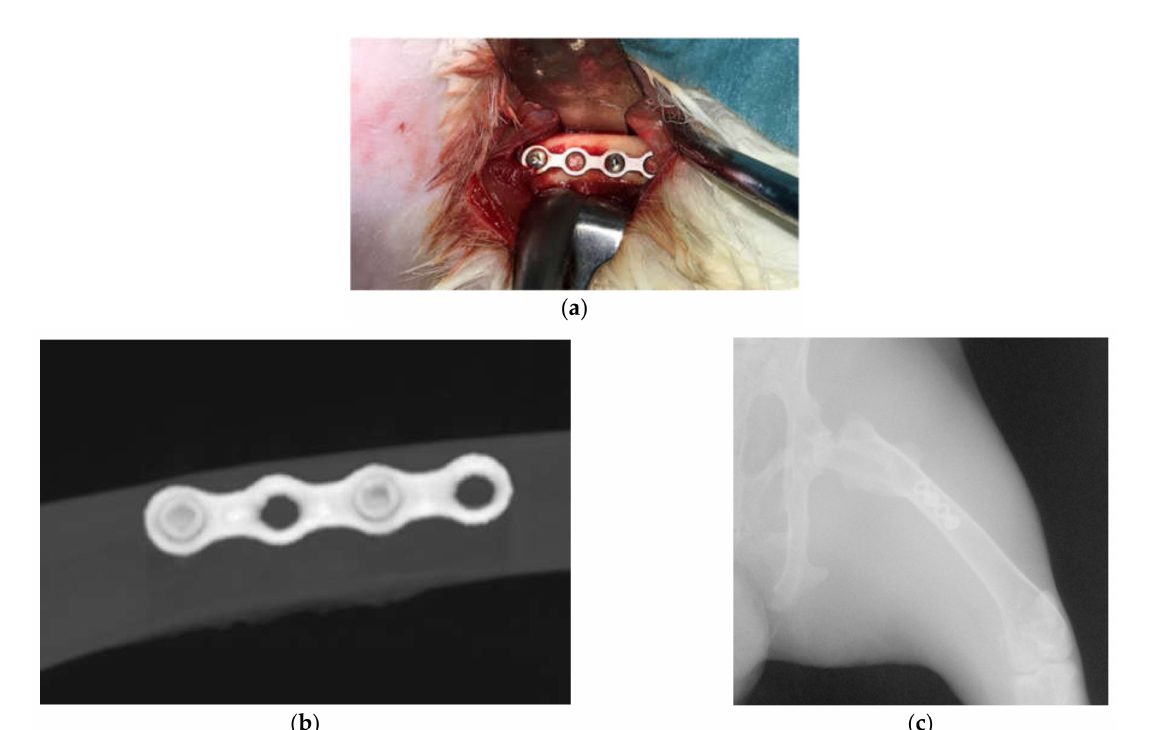
Figure 5. Titanium mini-plate inserted and secured with 2 titanium screws ( a ) a clinical picture, and ( b , c ) CT